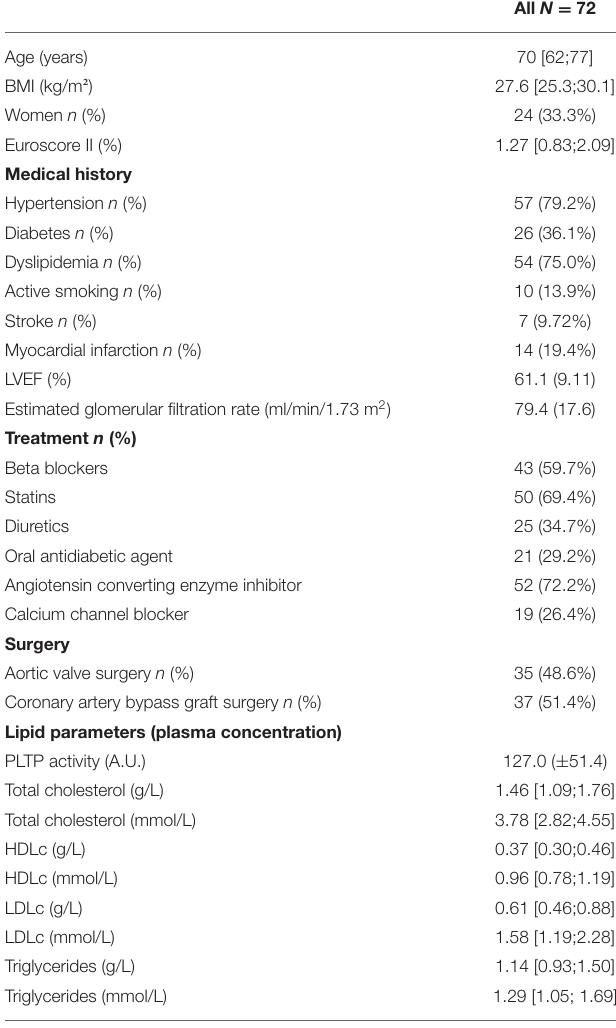
TABLE 1 | Baseline